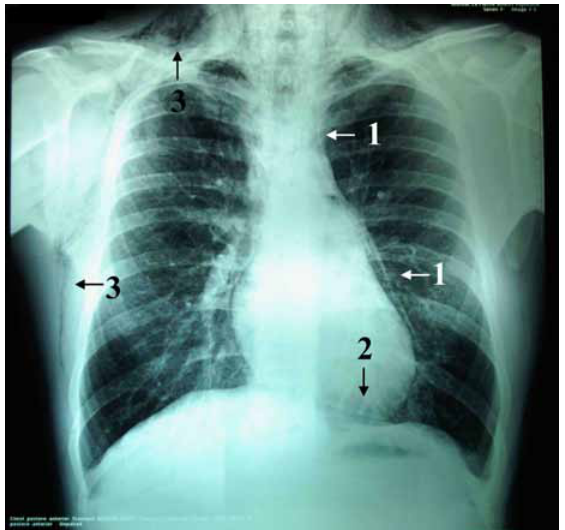
Figure 2. CT scan of the chest. Arrows pointing the air collections in the